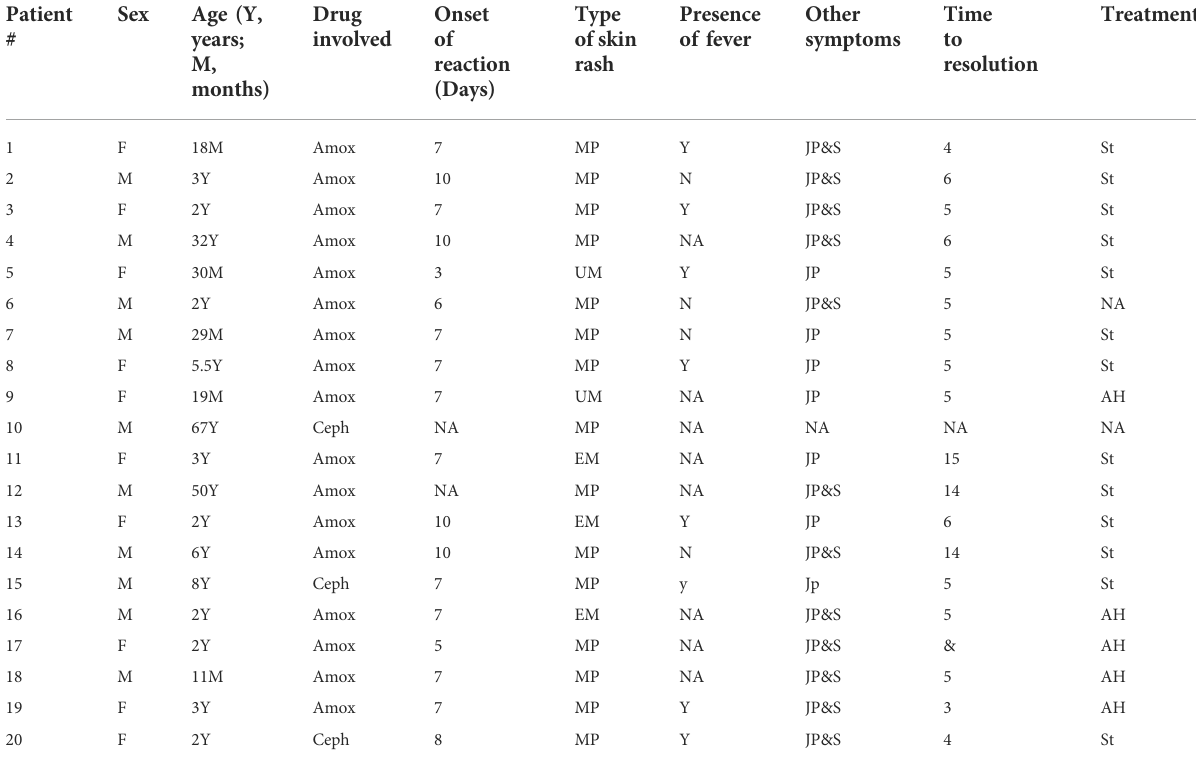
TABLE 1 Characteristics of patients included in the